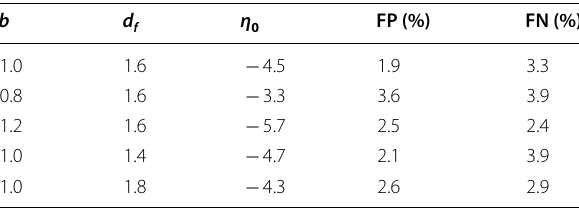
The input parameters, b and d f , take the values as shown above. The meaning of FP and FN is explained in Fig. 2a